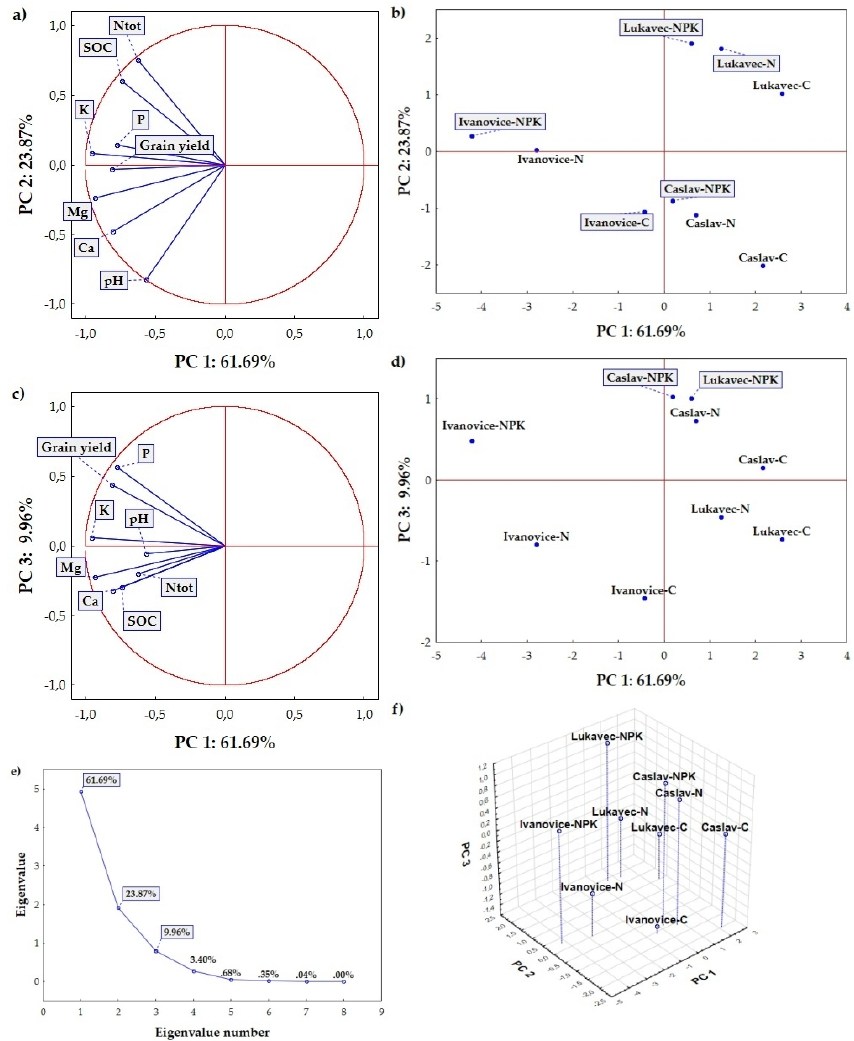
Figure 4. The results of the PCA, showing relationships between the analyzed soil parameters, grain yield and fertilizer treatment/locality. ( a ) PC1 and PC2—grain yield and soil properties, ( b ) PC1 and PC2—fertilizer treatments according to the locality, ( c ) PC1 and PC3—grain yield and soil properties, ( d ) PC1 and PC3—fertilizer treatments according to the locality, ( e ) eigenvalues, ( f ) 3D model showing PC1, PC2 and PC3 axis.